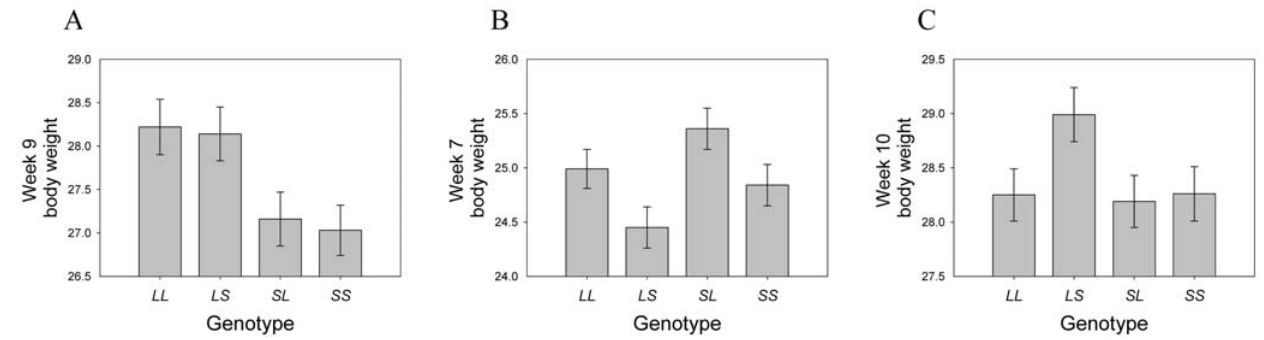
Figure 2. Three examples of imprinting patterns found in the genome-wide scan. Each of the four genotypes is shown with its corresponding average phenotype plus standard error of the mean at the locus. A) Wti1.1 serves as an example for paternal expression for week 9 body weight (g). B) Wti3.2 provides an example of bipolar dominance for week 7 body weight (g), C) Wti5.1 provides an example of polar overdominance for week 10 body weight (g).